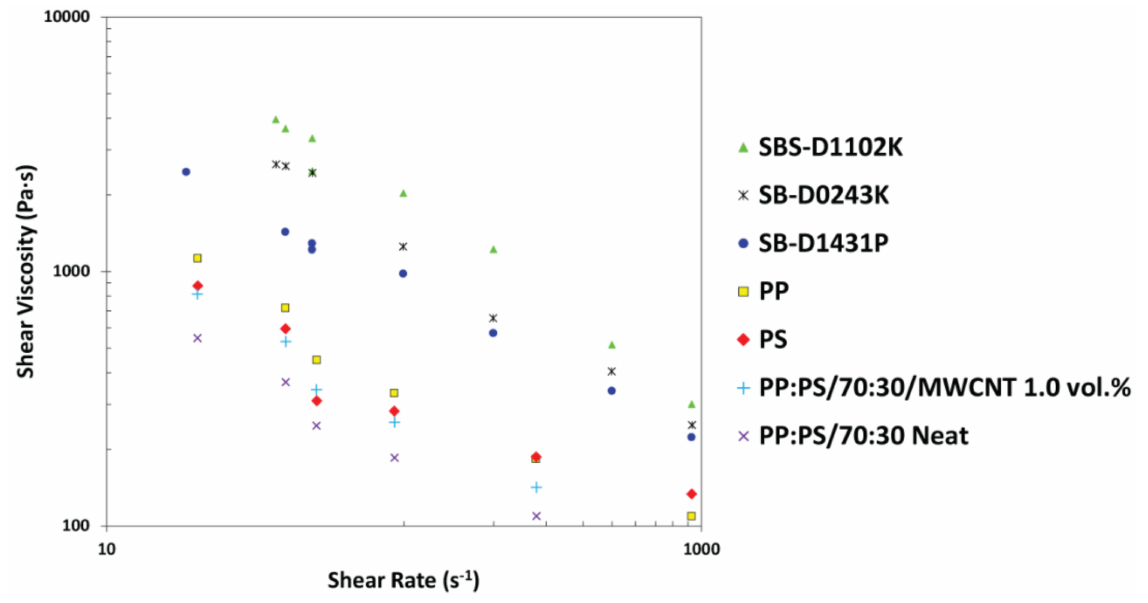
Figure 5. Shear viscosity measured by capillary rheology as a function of shear rate for neat PP, neat PS, and neat copolymers. Table 2. Hildebrand solubility parameters of PP, PS, (polybutadiene) PBD, and CNTs. Data were obtained from the literature.